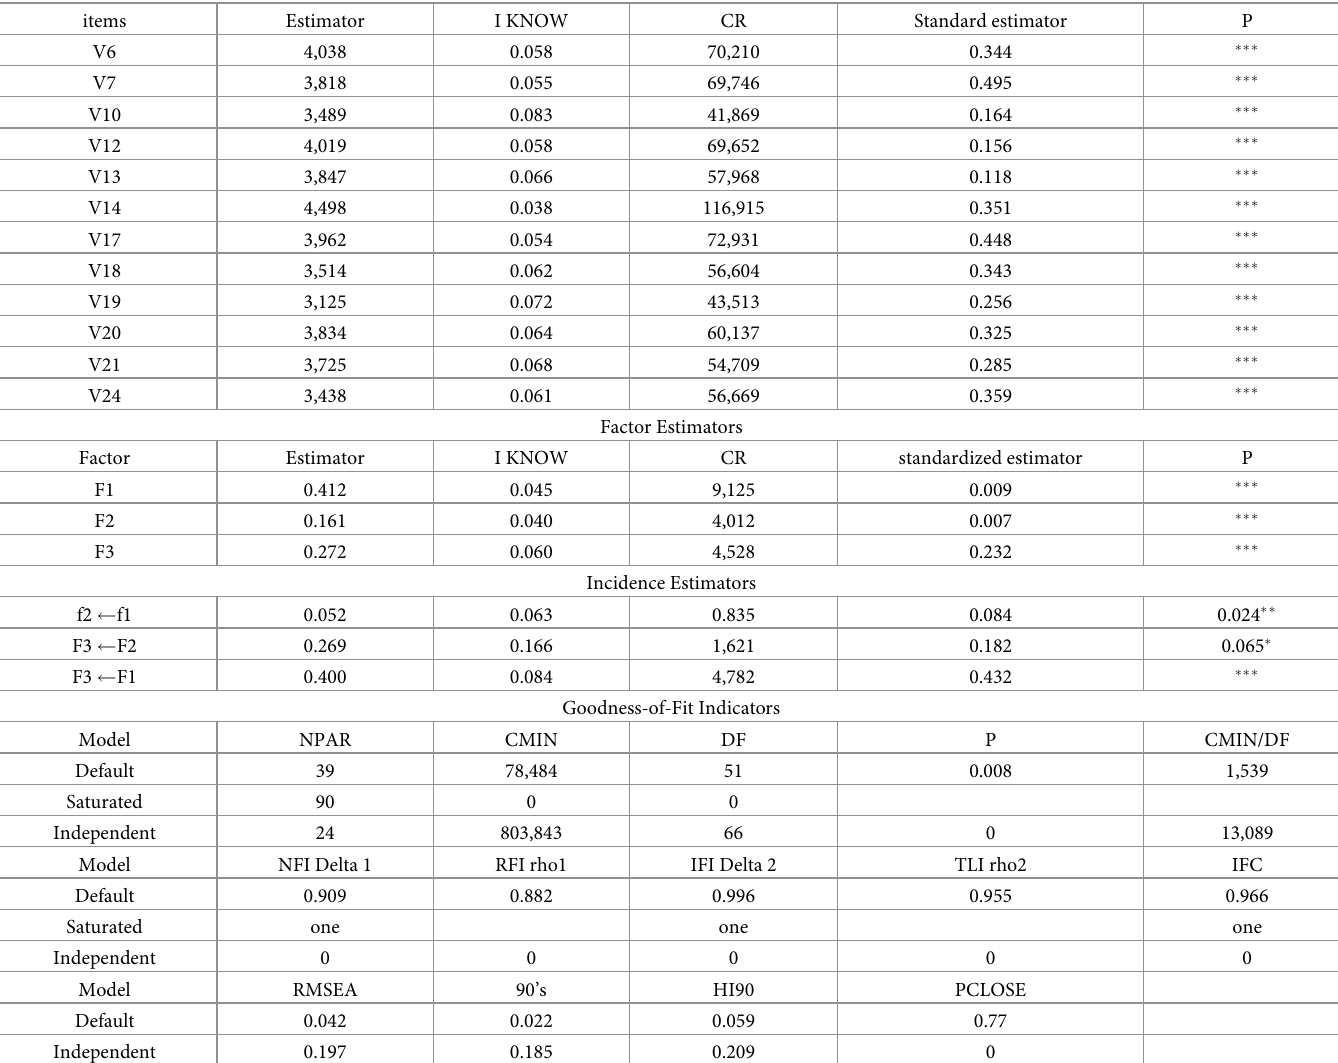
Table 4. Variance modeling